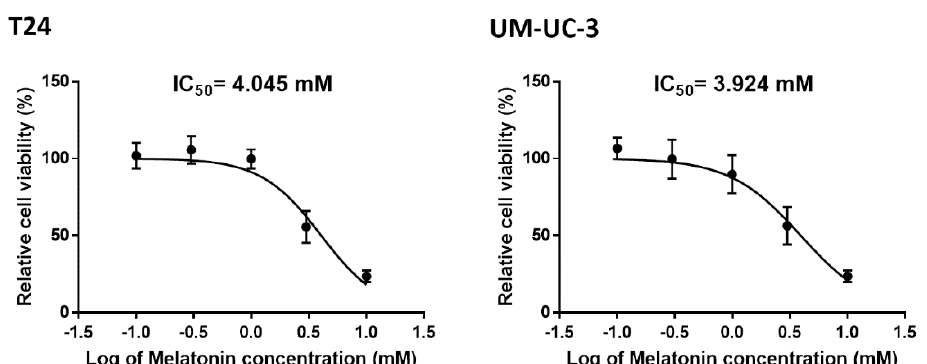
Figure 1. The cell viability of bladder cancer cells after melatonin treatment. T24 and UM − UC − 3 bladder cancer cells were incubated with melatonin (0, 0.1, 0.3, 1 or 3 mM) for 24 h, and cell viability was determined by MTT assay. The IC50 were calculated in both cells and provided in the figures.